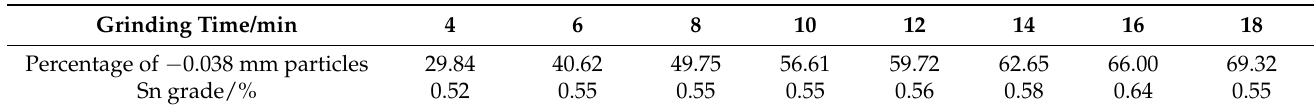
Table 1. Percentage of − 0.038 mm particles and the Sn grade in this size fraction with different grinding